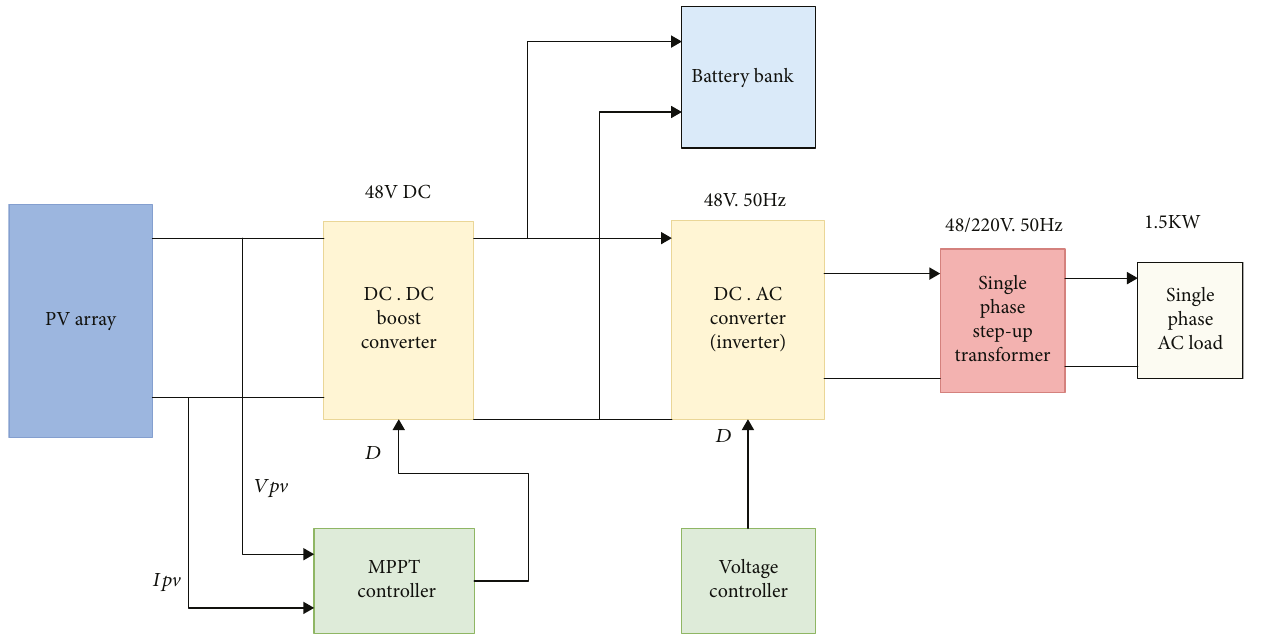
Figure 8: Proposed PV system block diagram.